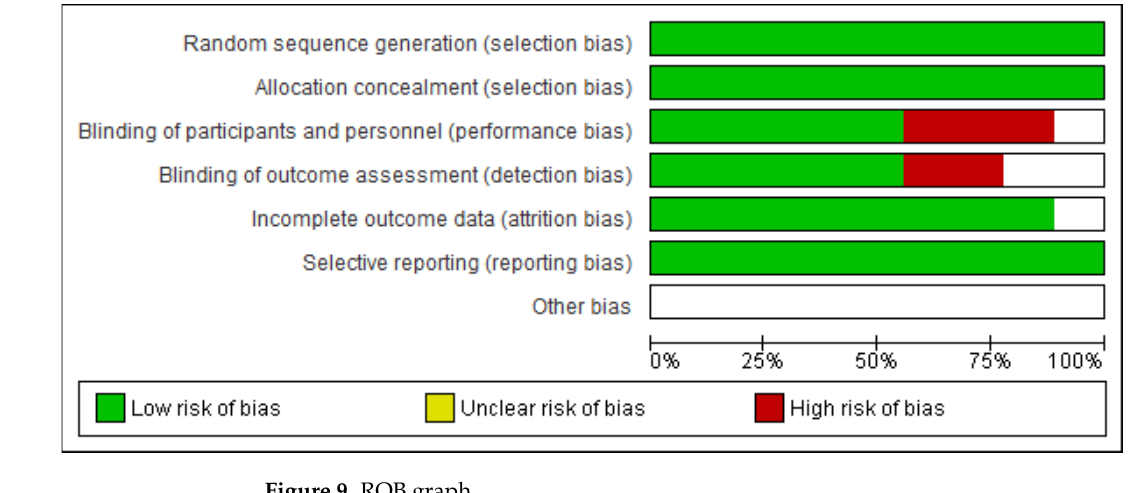
Figure 9. ROB graph.